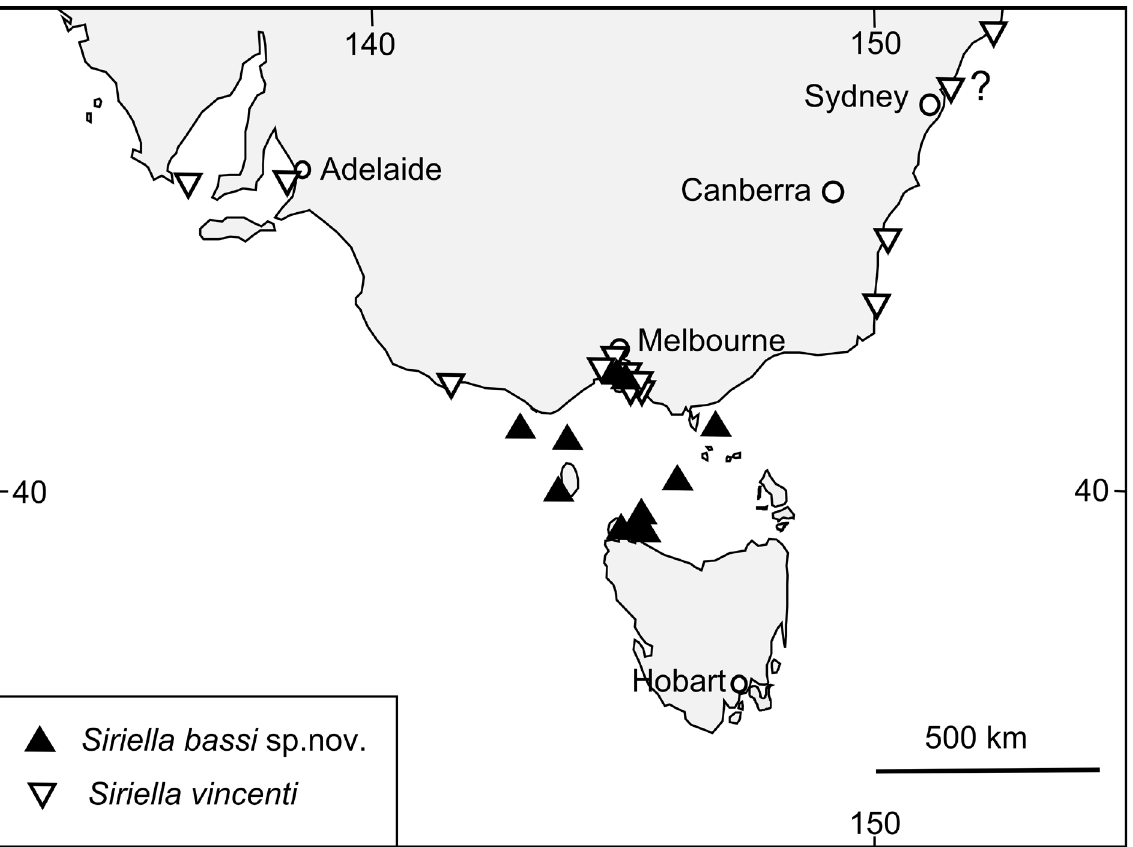
Fig. 2. Distribution of species in the Siriella brevicaudata species group along the southern Australian